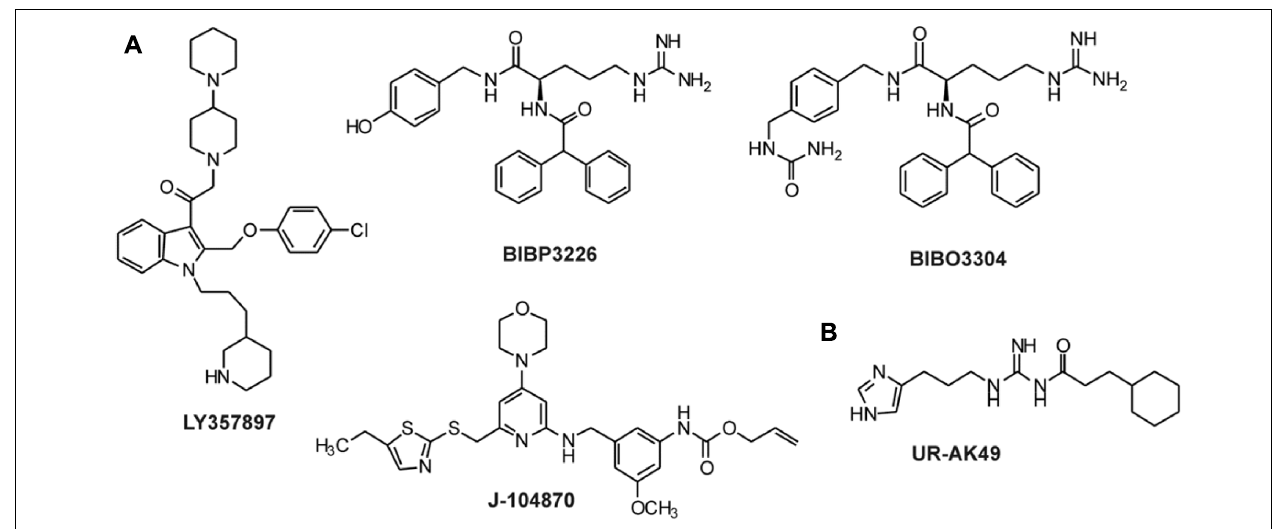
FIGURE 4 | Non-peptidic antagonists forY 1 andY 4 receptors. (A) Antagonists for theY 1 receptor (Rudolf etal., 1994; Hipskind etal., 1997;Wieland etal., 1998; Balasubramaniam etal., 2001; Sjodin etal., 2006; Antal-Zimanyi etal., 2008); (B) Antagonists for theY 4 receptor (Ziemek etal., 2007).